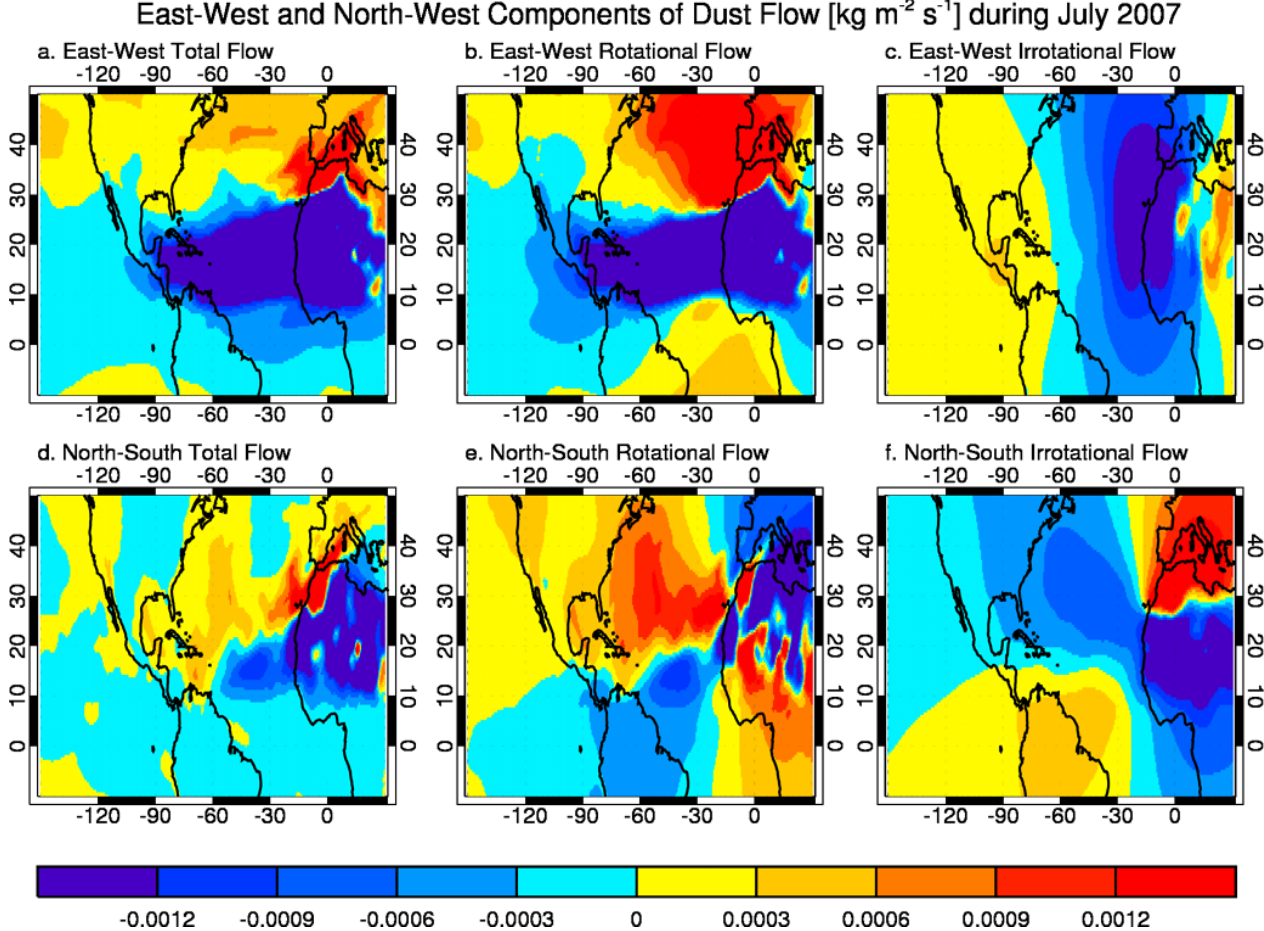
Fig. 13. East-west (top) and north-south components (bottom) of the total (left), rotational (center), and divergent (right) flow. Table 1. Net northward mass transport and mass loss from removal and relative contribution, westward mass transport at entrance and exit of barrier region, and mass, total AOT, and coarse mode barrier efficiencies for all simulations and MODIS-Terra. Experiment/Satellite Net Northward Net Mass Loss from 80 ◦ W, 90 ◦ W, and Barrier Mass Transport (Tg) and Removal (Tg) and Net Change in Westward Efficiency Coarse Barrier Contribution (%) Barrier Contribution (%) Transport (Tg) Mass Total AOT Mode AOT 1.